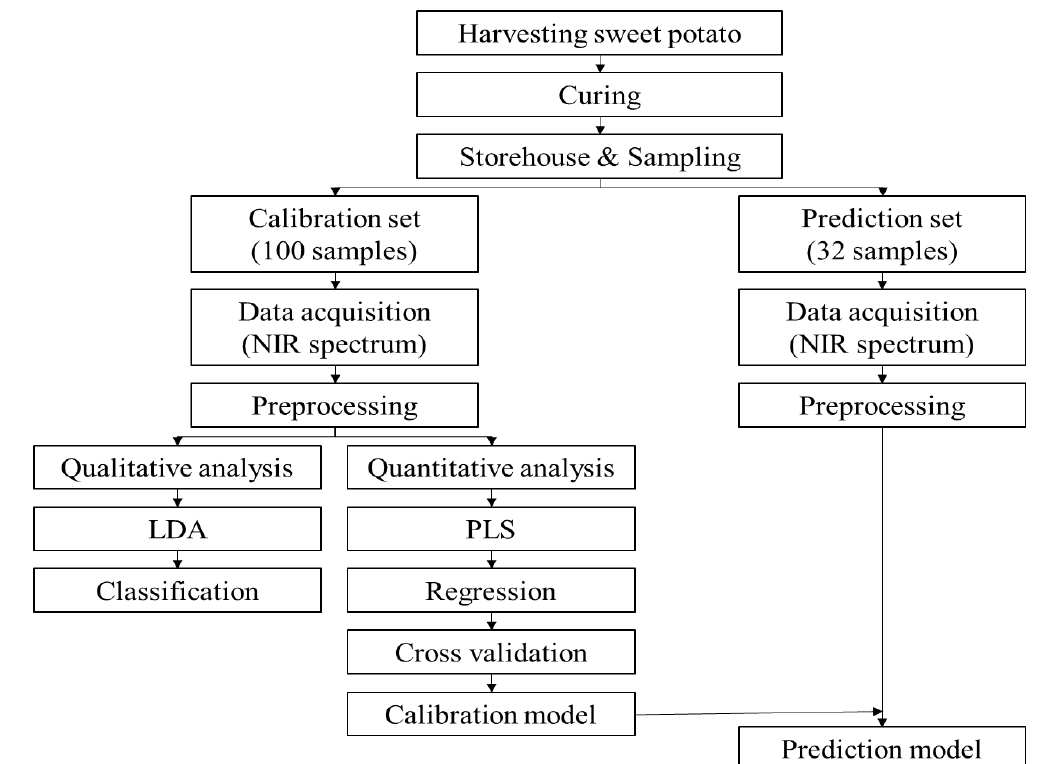
Figure 2. Schematic of NIR spectrum analysis applied to develop the prediction model using classification and regression of the internal quality of sweet potatoes (LDA: linear discriminant analysis, PLS: Partial least squares).